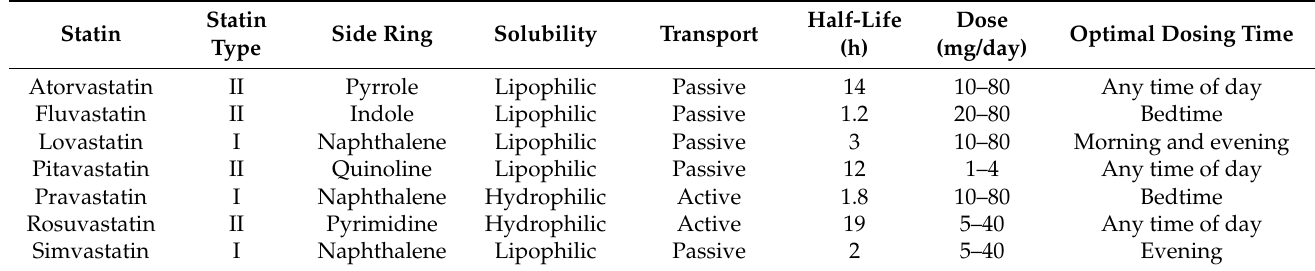
Table 1. Molecular and solubility characteristics of the different